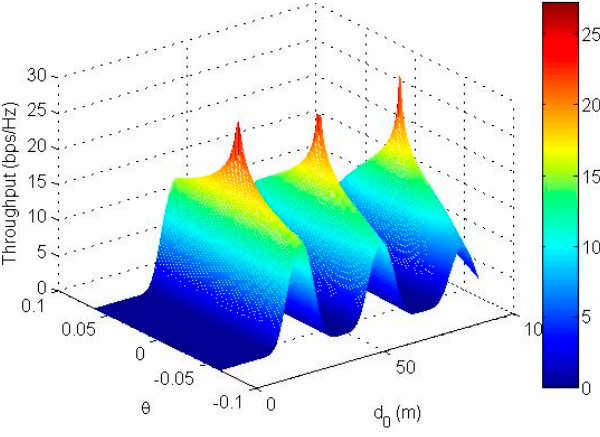
Figure 6. Throughput versus the user equipment (UE’s) locations ( N = 15 ).